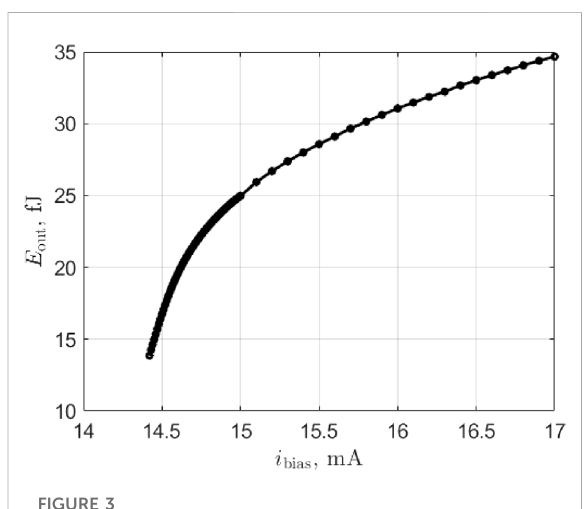
FIGURE 3 Outputpulseenergyvsbiascurrentofthegainsectionforthe laser-neuron. Self-pulsating threshold is i bias = 14.4